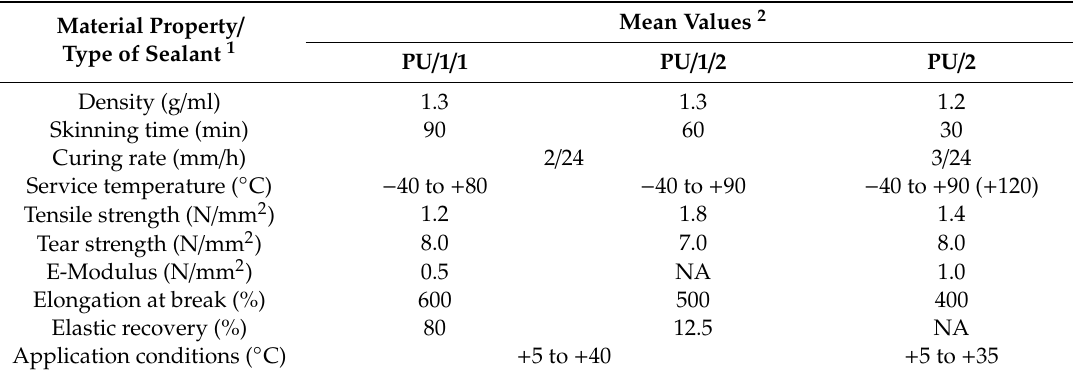
Table 2. Technical data and physical / mechanical properties of polyurethanes.